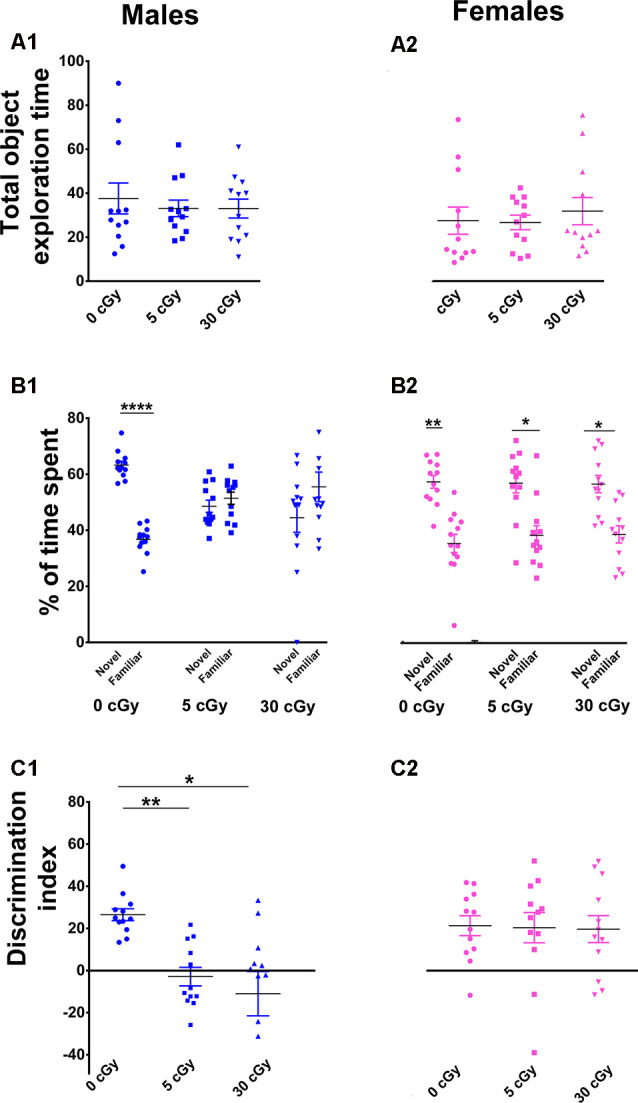
Exposure to 4He ions impairs Novel Object Recognition (NOR) in male but not female mice. Irradiation had no effect on total exploration time during the NOR task (A1,A2). Irradiated male mice showed diminished preference for novelty (B1), while irradiated female mice showed a higher preference for novelty (B2). Two-way ANOVA on discrimination index (DI) revealed a significant interaction between sex and radiation (p = 0.048), as well as a significant sex effect (p < 0.0001), but no main effect of radiation (p = 0.10). Post hoc analysis showed that DI was reduced significantly in male mice following irradiation, but not in female mice (C1,C2). Unlike males, female mice showed no indication of cognitive deficits following irradiation. N = 12 for each experimental group. Individual animals represented as dots; lines depict group means and SEM. *p < 0.05, **p < 0.01, ****p < 0.0001.